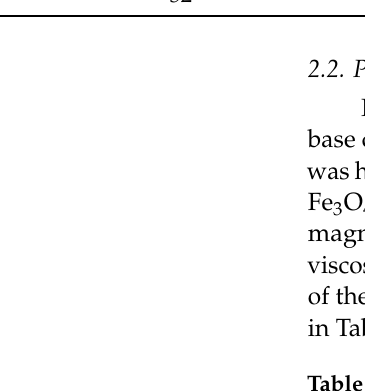
Table 1. Basic physical parameters of L-AN32 base carrier.